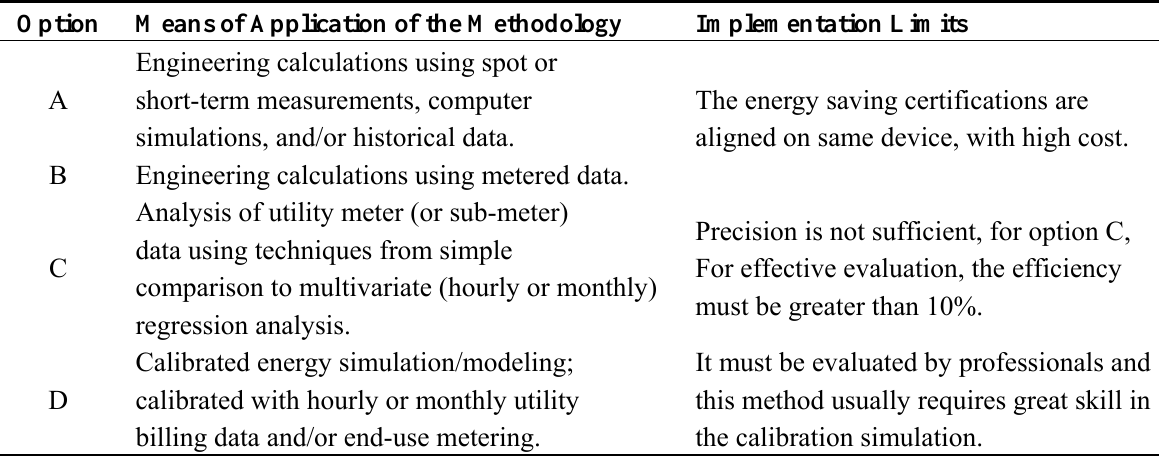
Table 1. Summary of options A, B, C and D of the IPMVP and their limitations in implementation for reporting energy saving amounts